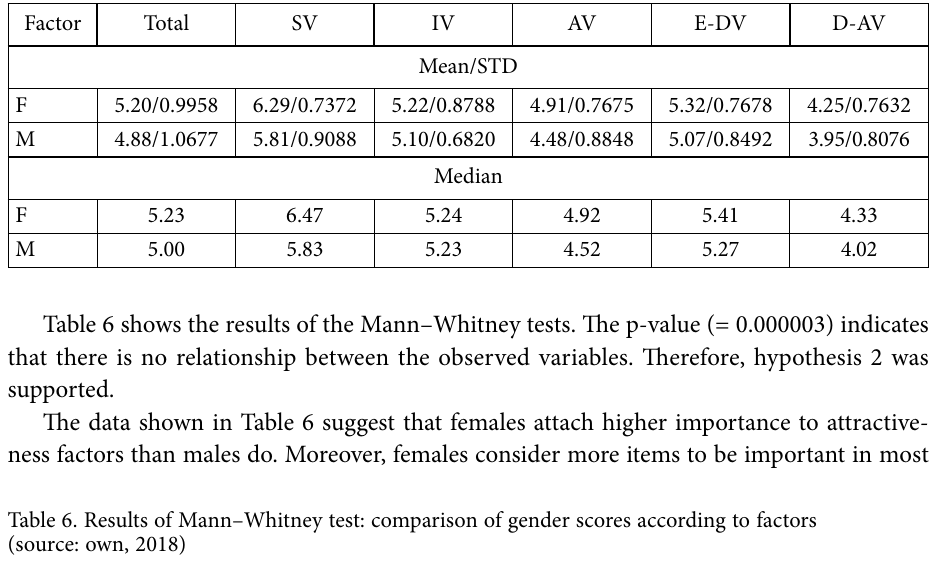
Table 5. Gender sample parameters according to factors (source: own, 2018) Factor Total SV